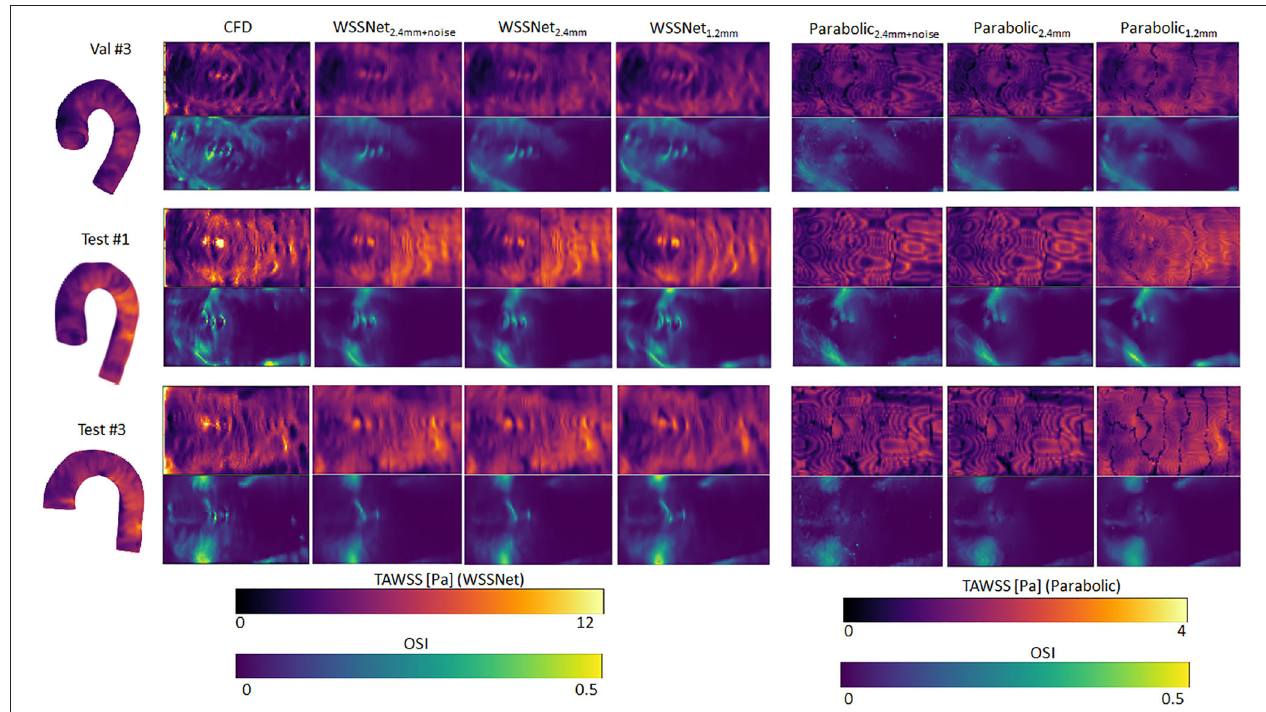
FIGURE 9 | Time-averaged WSS and OSI comparison between WSSNet and parabolic fitting method at a different spatial resolution of synthetic MRI (dx = 2.4mm, 2.4mm with noise and 1.2mm). For reference, TAWSS and OSI flatmaps from ground truth CFD are provided in the left-most column. TAWSS derived from the parabolic method were much lower and showed different dynamic ranges (0–4Pa) to highlight pattern similarity between methods. 3D representations of the TAWSS from WSSNet 2.4 + noise are shown on the left side of each flatmap.